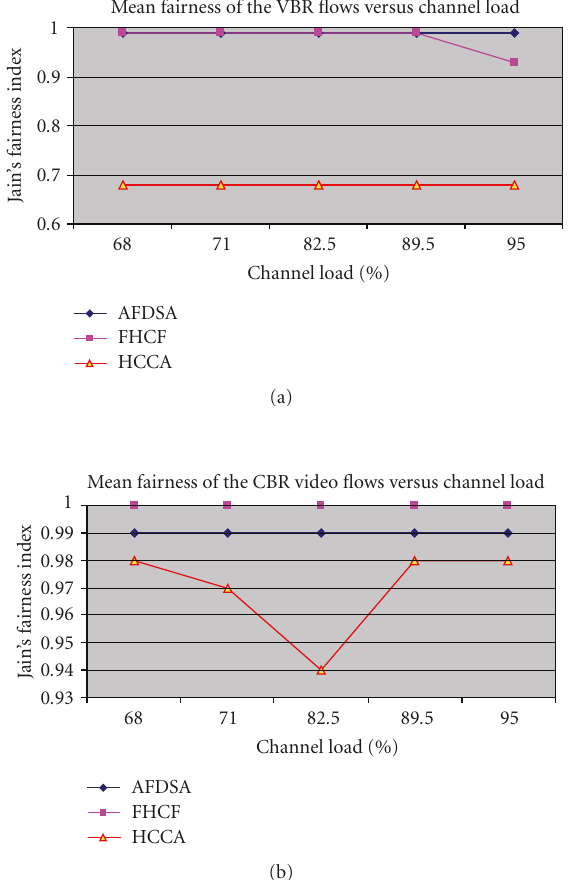
Figure 14: HCCA latency.